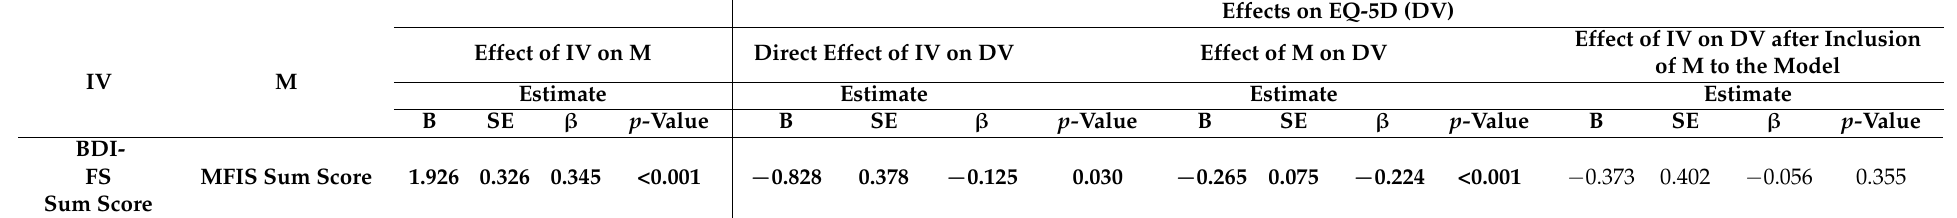
Table 2. Univariable and multivariable results of the variables meeting the mediator criteria according to Baron and Kenny (1986) [48], adjusted 1 ( n = 206) 2